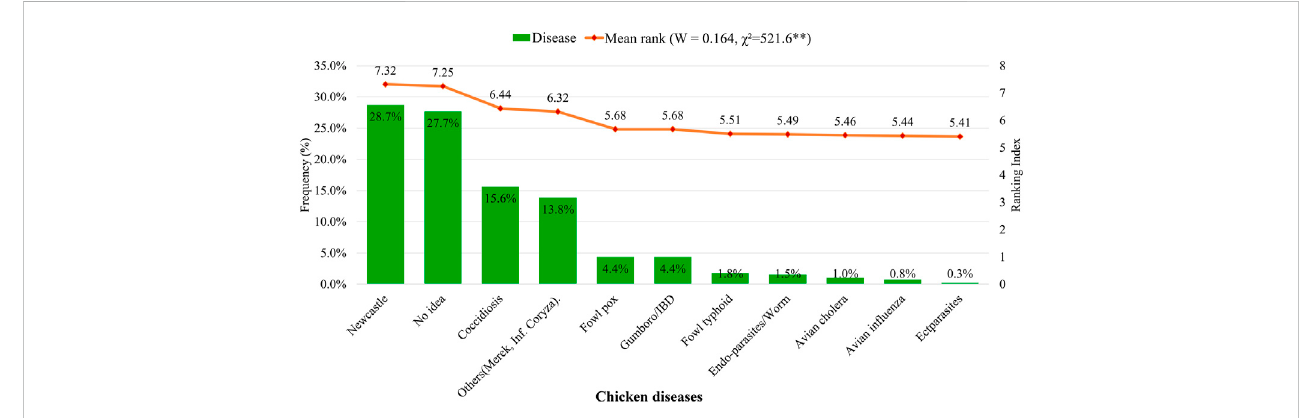
FIGURE 3 Disease prevalence in indigenous chickens of Uganda as described by households. W = Kendall ’ s coef fi cient of concordance. x 2 = chi-squared.** p <